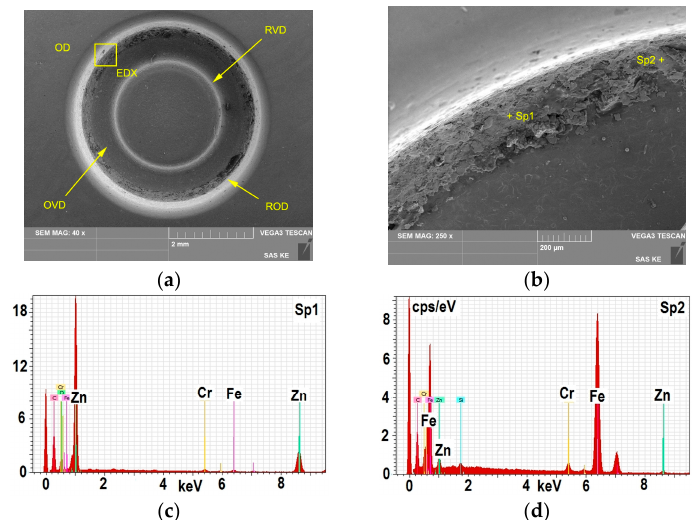
Figure 13. CrN die-defect in the radius surrounding the cavity of the shaped surface ROD: ( a ) wear disposition of the shaped part of the die; ( b ) detail of ROD; ( c ) EDX microanalysis of Sp1 area; ( d ) EDX microanalysis of Sp2 area. Metals 2017 , 7 , 515